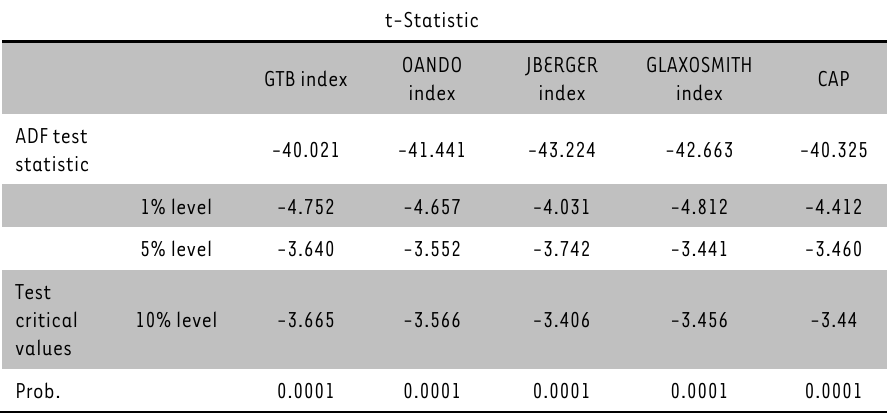
TABLE 2: ADF test for NSE index